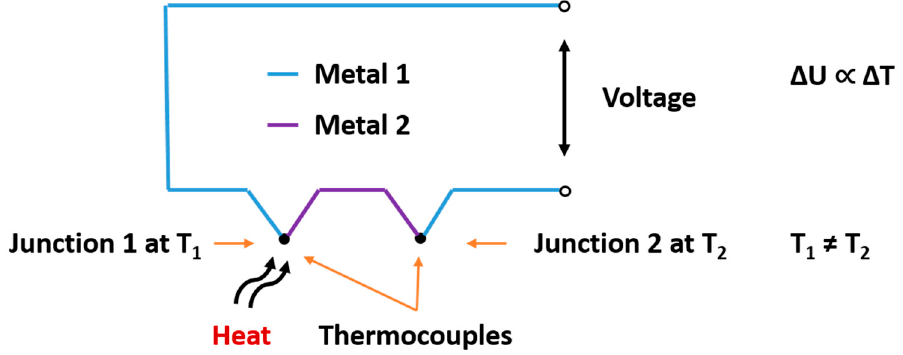
Figure 2. The first junction is heated to T 1 while the second junction stays at temperature T 2 . According to [15], this results in an analog voltage signal.